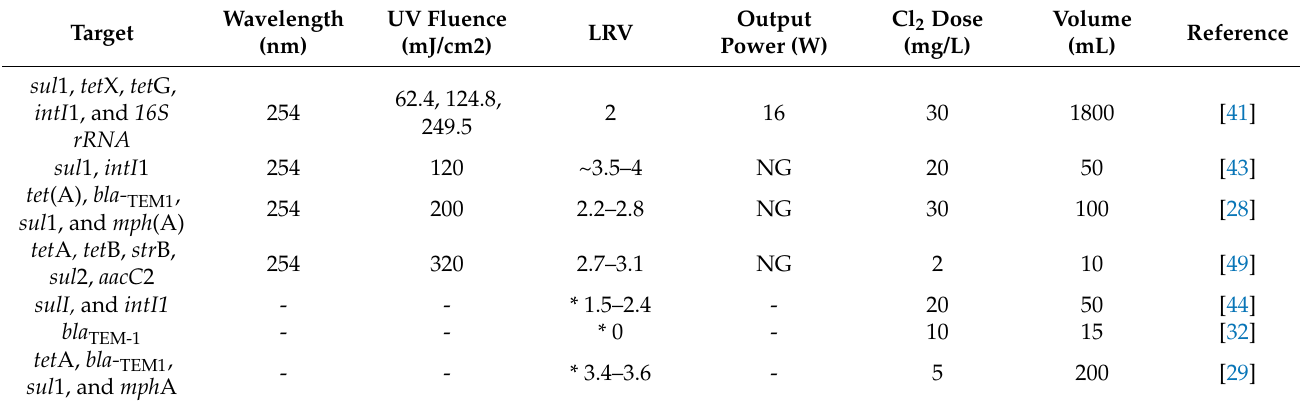
Table 2. Inactivation of ARGs by chlorine and